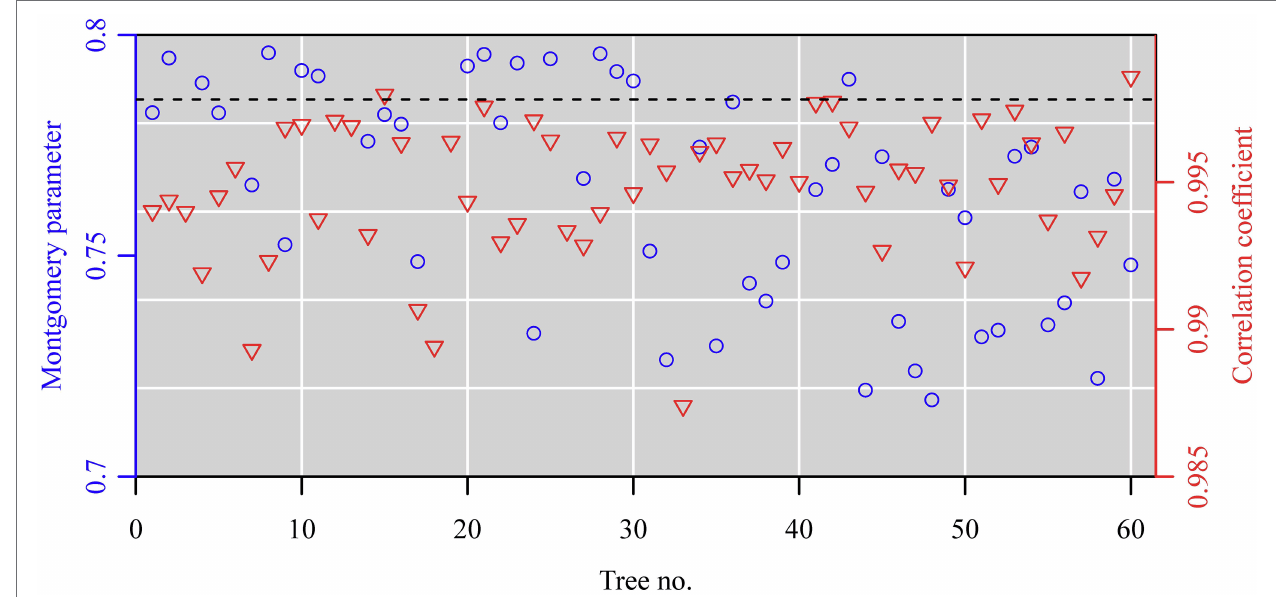
FIGURE 4 | The estimates of the Montgomery parameters (blue open circles) and correlation coefficients (red open lower triangles) for the leaves sampled from each of the 60 trees. Each Montgomery parameter (MP) was estimated as a proportionality coefficient for leaf area = MP × leaf length × length width on a log–log scale, and the correction coefficient was used to reflect the linear degree between leaf area and the product of leaf length and width on a log–log scale.